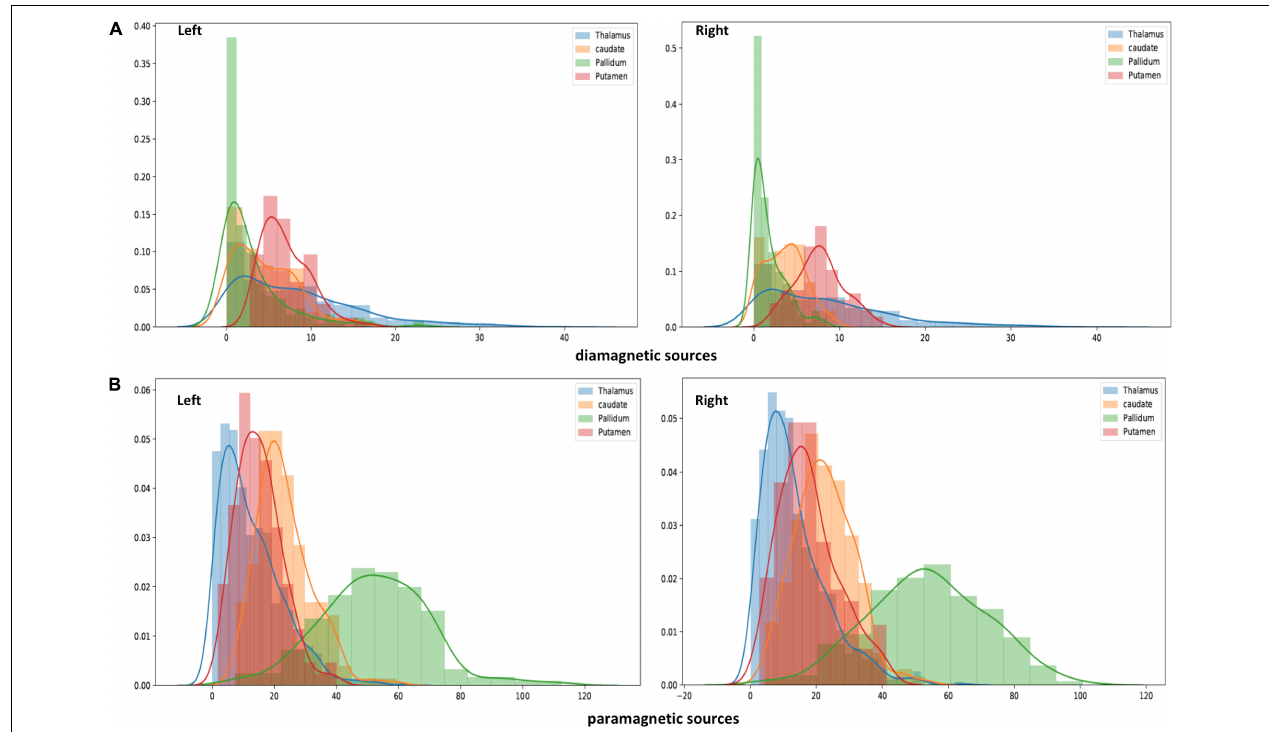
FIGURE 7 | Histogram of QSM-values in diamagnetic (A) and paramagnetic sources (B) : Distribution of mean di- and paramagnetic sources within Th and BG. The different colors indicate corresponding structures. The X-axis depicts different QSM values and the Y-axis depicts the amount of each value. Note the differences, where the diamagnetic source, the pallidum, shows the first peak, caudate the second, putamen the third, and Th in the last, while for the mean paramagnetic source, Th shows the first peak, putamen the second, caudate the third, and pallidum the last. Overall, the diamagnetic sources span a more narrow range of values than paramagnetic sources.